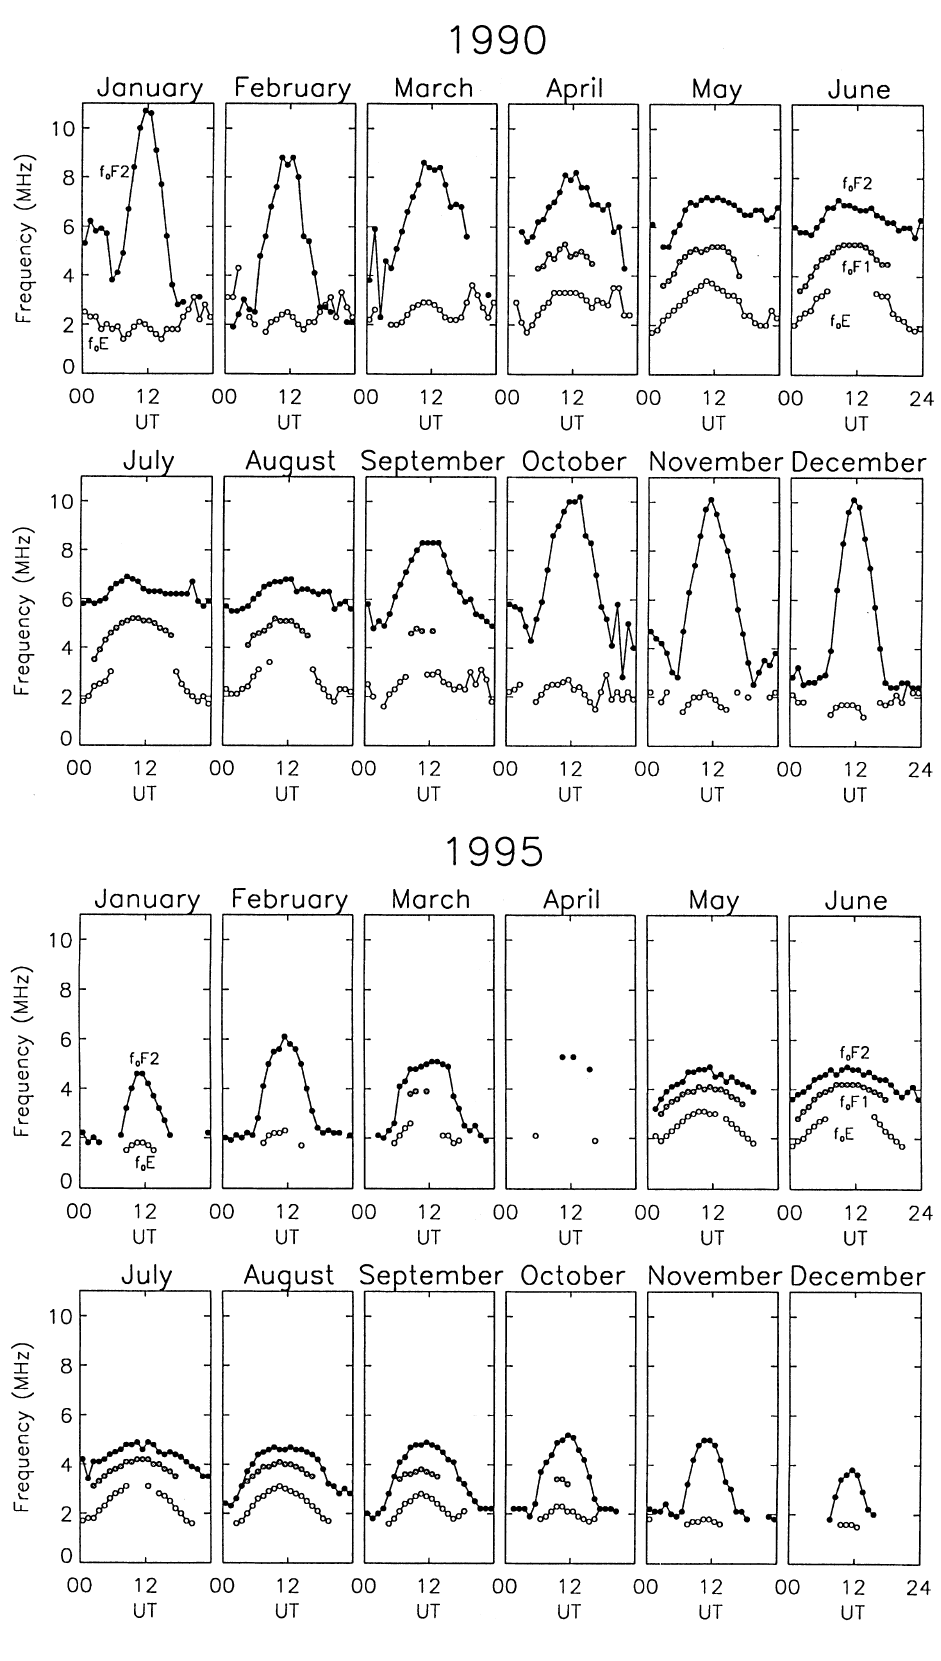
Fig. 6. Monthly median values of ionospheric parameters from the Sodankyla¨ ionosonde for near solar maximum conditions (1990) and near solar minimum condi-